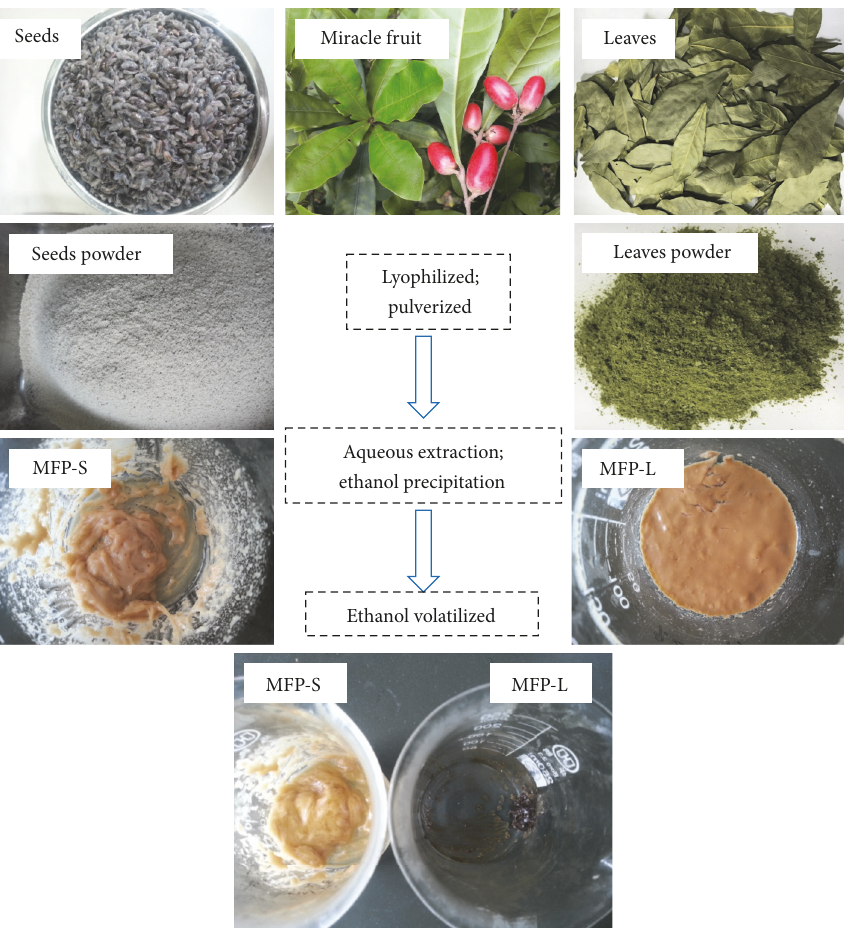
Figure 1: Preparation processes of MFP-S and MFP-L with aqueous extraction, followed by ethanol